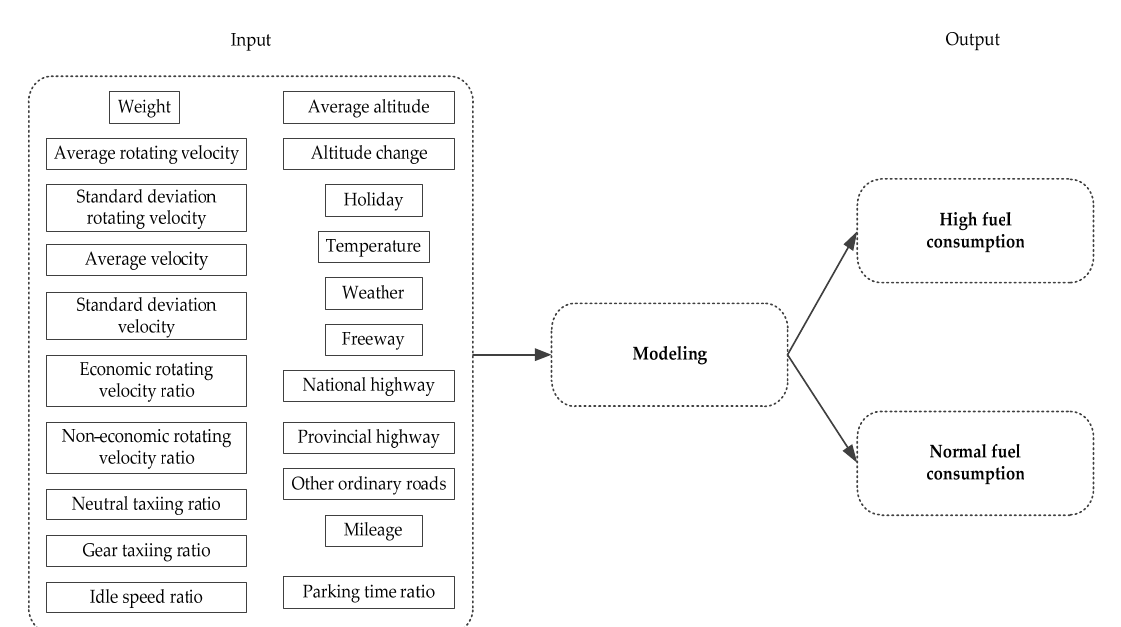
Figure 5. The simple logical framework of input/output variables.